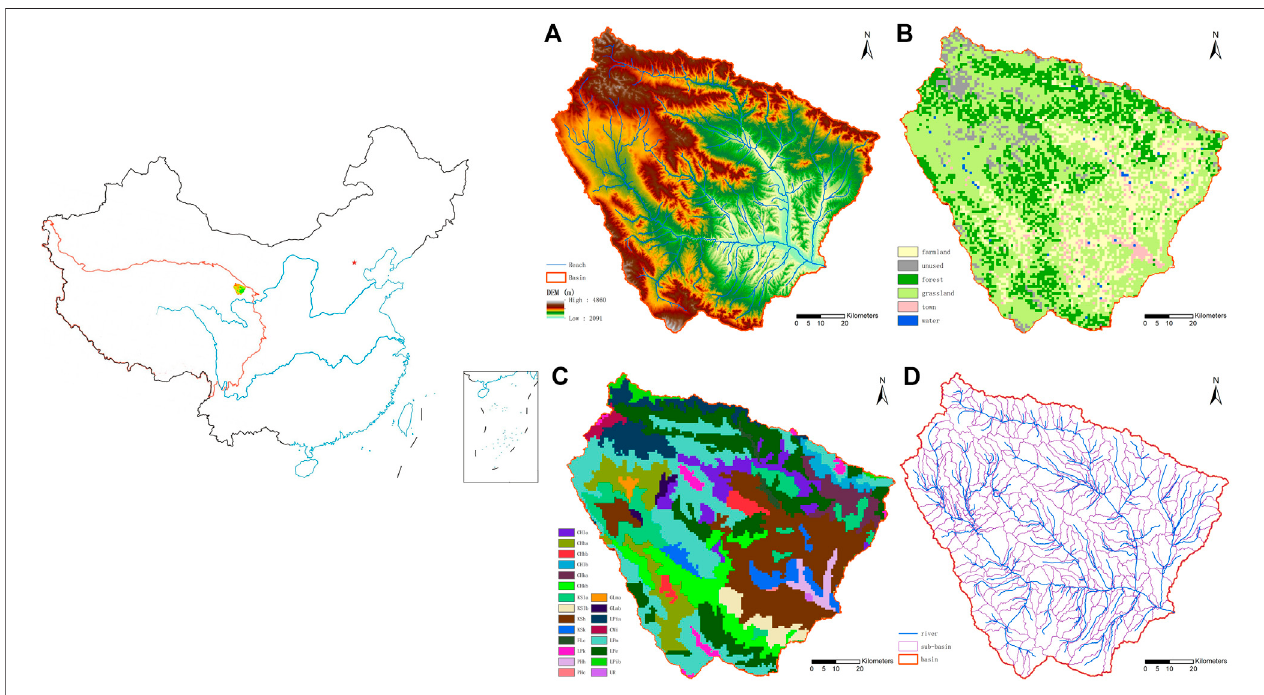
FIGURE 3 | The graphic digital elevation model (DEM) data (A) , land use data (B) , soil data (C) , and the divided threshold of the basin (D) .